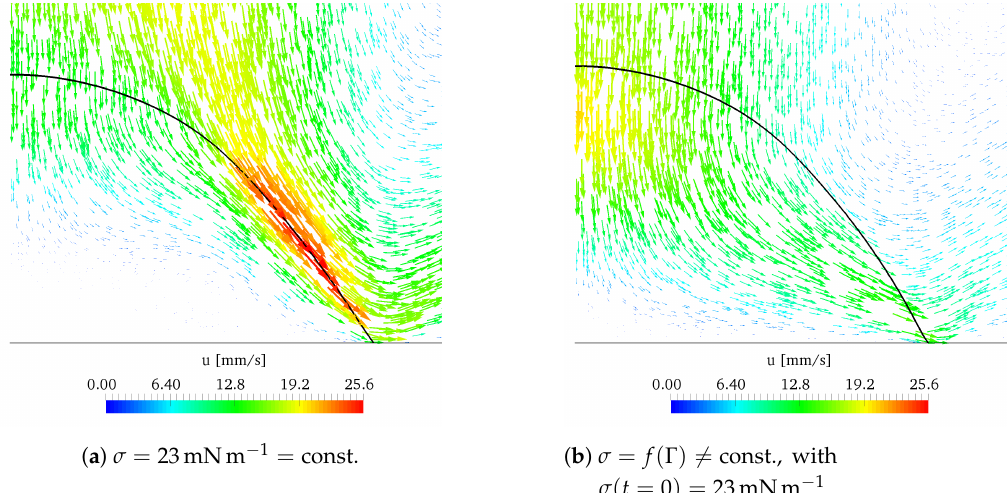
Figure 6. Velocity field in droplet and surrounding gas phase after 0.1ms for different surface tension models.